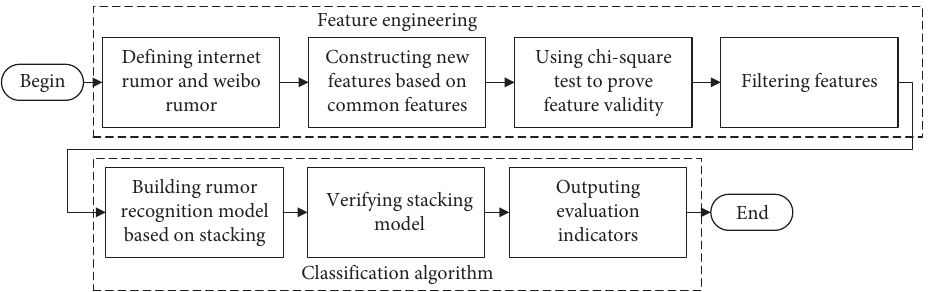
Figure 2: Rumor recognition